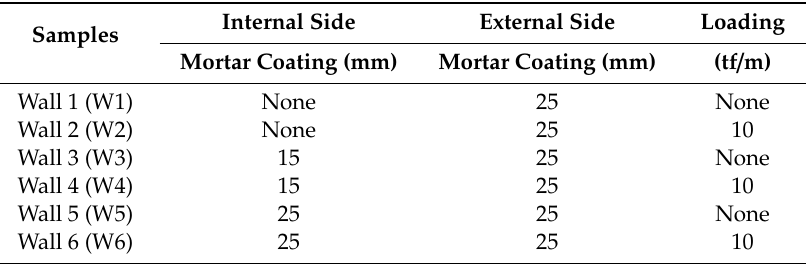
Table 1. Sample nomenclature.